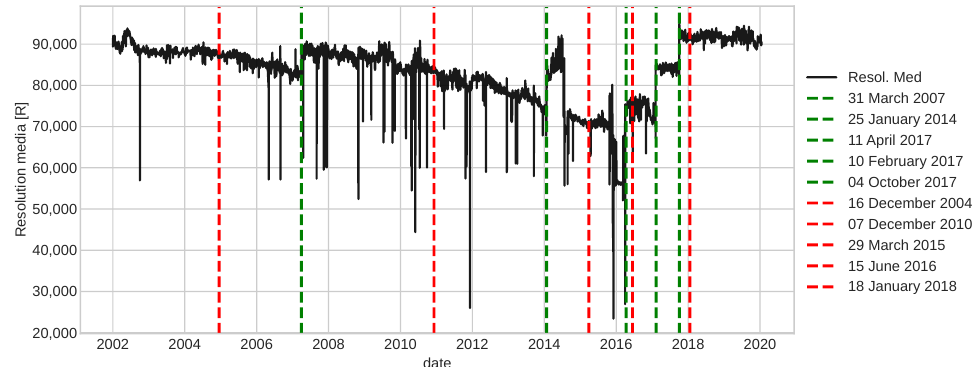
Figure 14. Fault detection in the resolution media signal obtained from a